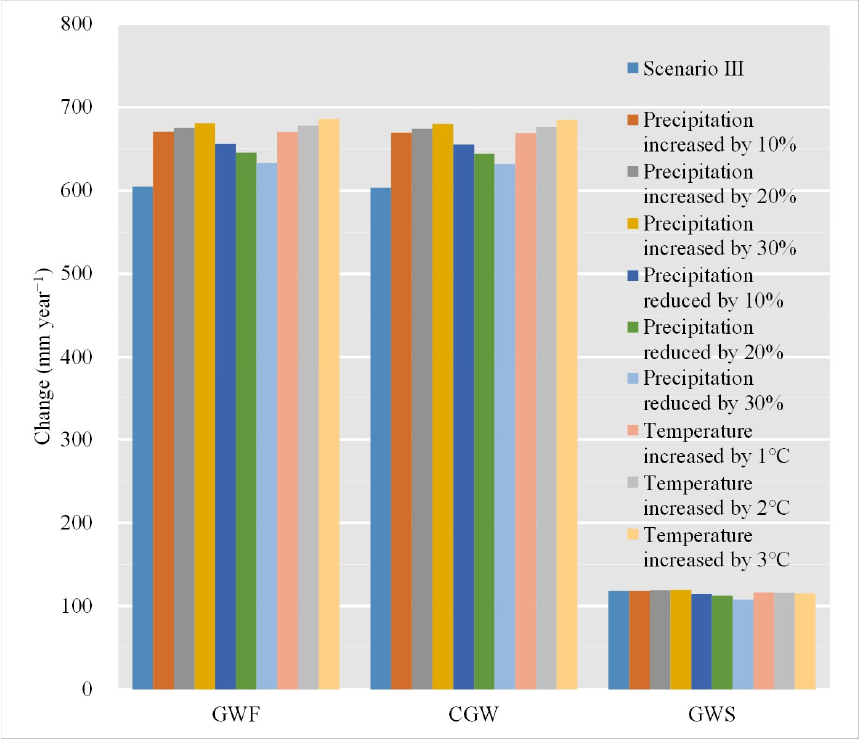
Figure 11. Simulation of the annual mean values of GWS, GWF, and its components (CGW) in the upper Ganjiang River basin by individually altered precipitation and temperature factors based on Scenario III.